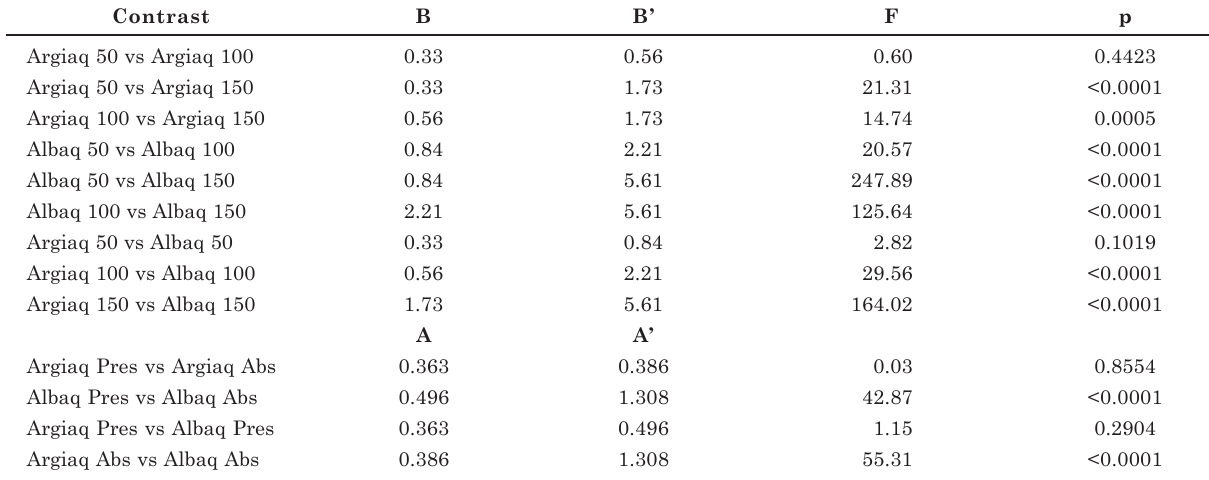
Table 7. Means, F statistics and “p” probability of univariate orthogonal contrasts for the hypotheses of